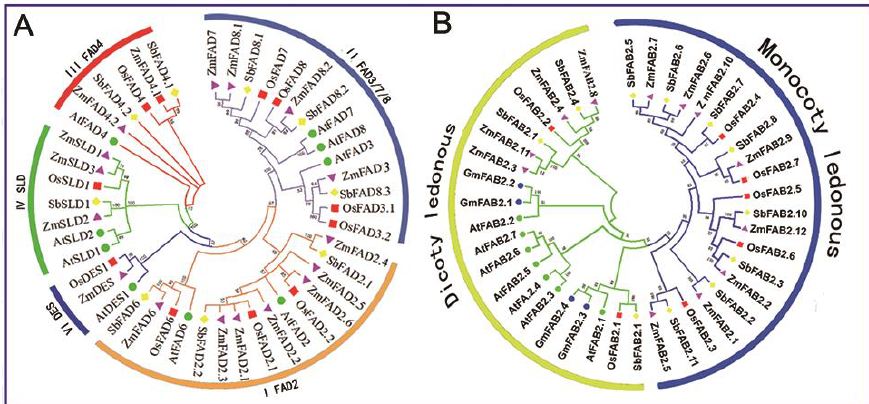
Figure 1. Phylogenetic relationships of fatty acid desaturases (FADs) in different plant species. ( A ) Membrane-bound FADs; ( B ) Soluble FAB2s. The full-length amino acid sequences of FADs from maize ( Z. mays ), Arabidopsis ( A. thaliana ), rice ( O. sativa ), sorghum ( S. bicolor ), and soybean ( G. max ) were obtained from an online NCBI database. The phylogenetic trees were constructed using the MEGA 5.0.